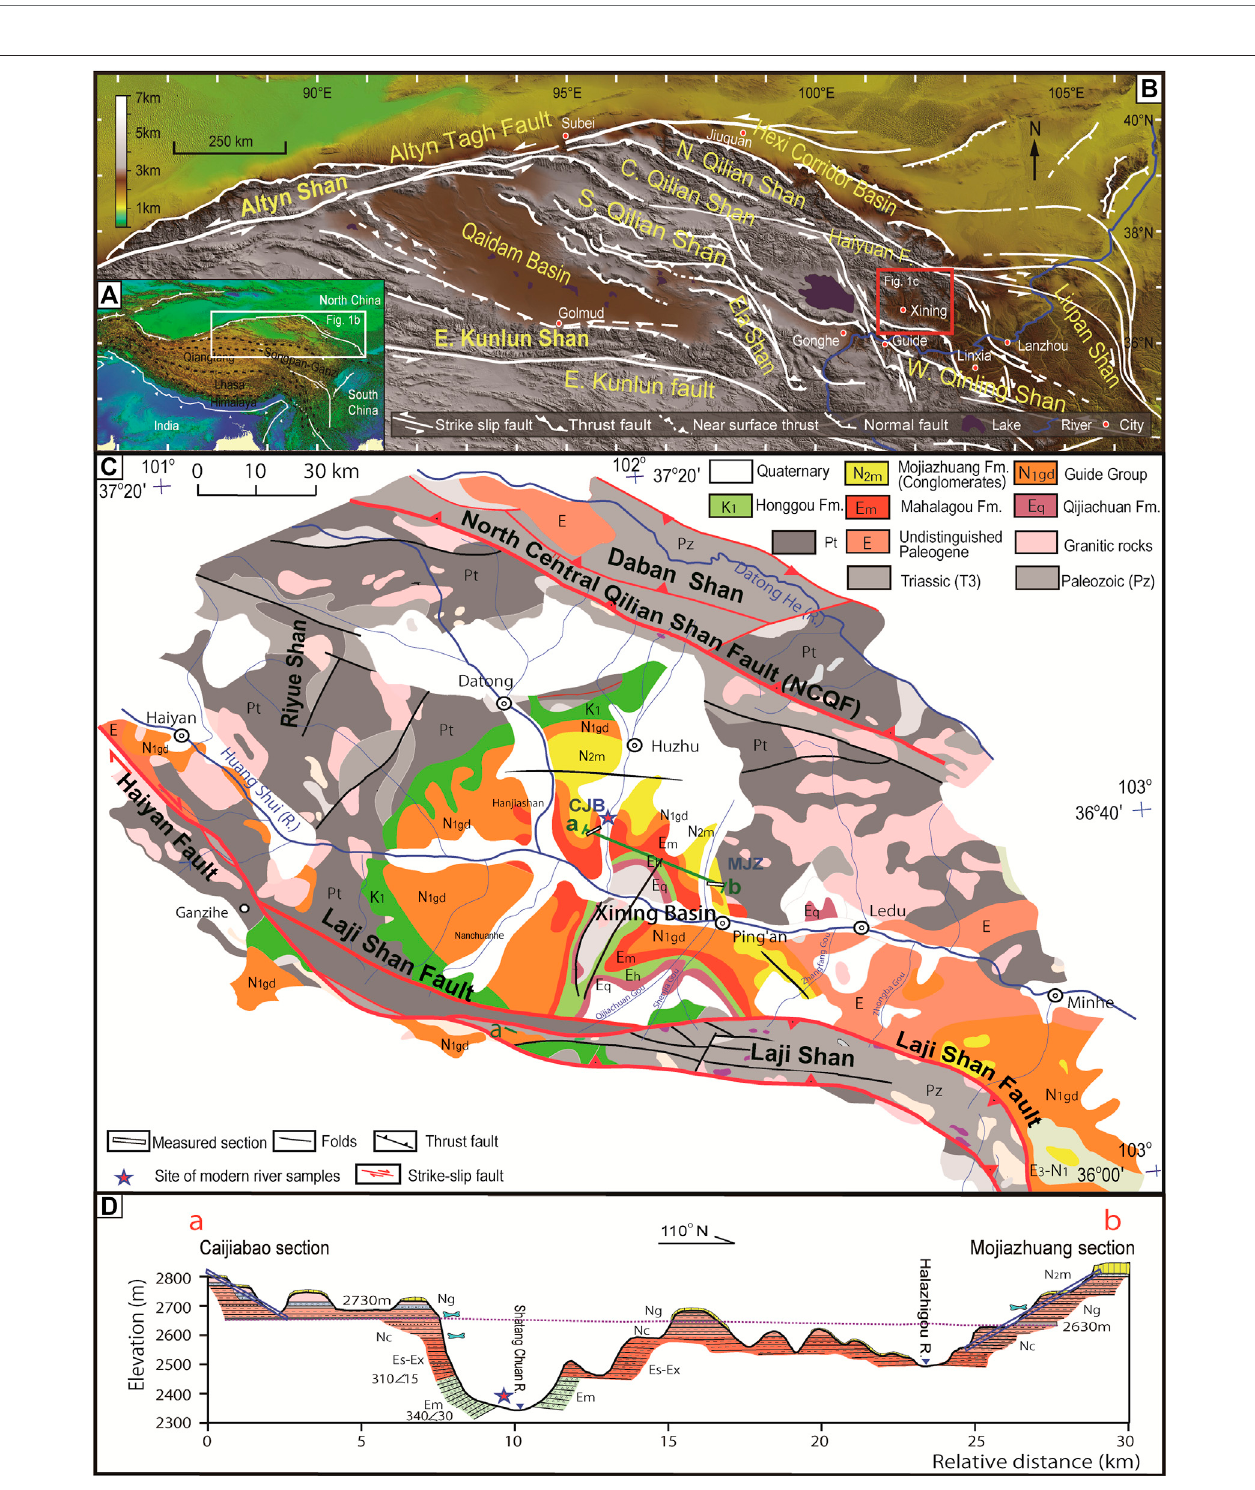
FIGURE 1 | Geologic survey of the study area on the Tibetan Plateau. (A) Digital topographic elevation model of the northeastern Tibetan Plateau mainly indicates the location of the Qilian Shan geomorphology and adjacent basins. (B) Topography of the major faults in the TP and Qilian Shan in the northeastern region and the periphery. (C) Distribution of the Cenozoic stratigraphy of the XB and locations of the CJB (Caojiabao) and MJZ (Mojiazhuang) sections (modi fi ed from Dai et al., 2005). (D) Sections a – b show the relationships between the Cenozoic stratigraphy and the CJB and MJZ sections for the top sequences (modi fi ed from Zhang et al., 2017).